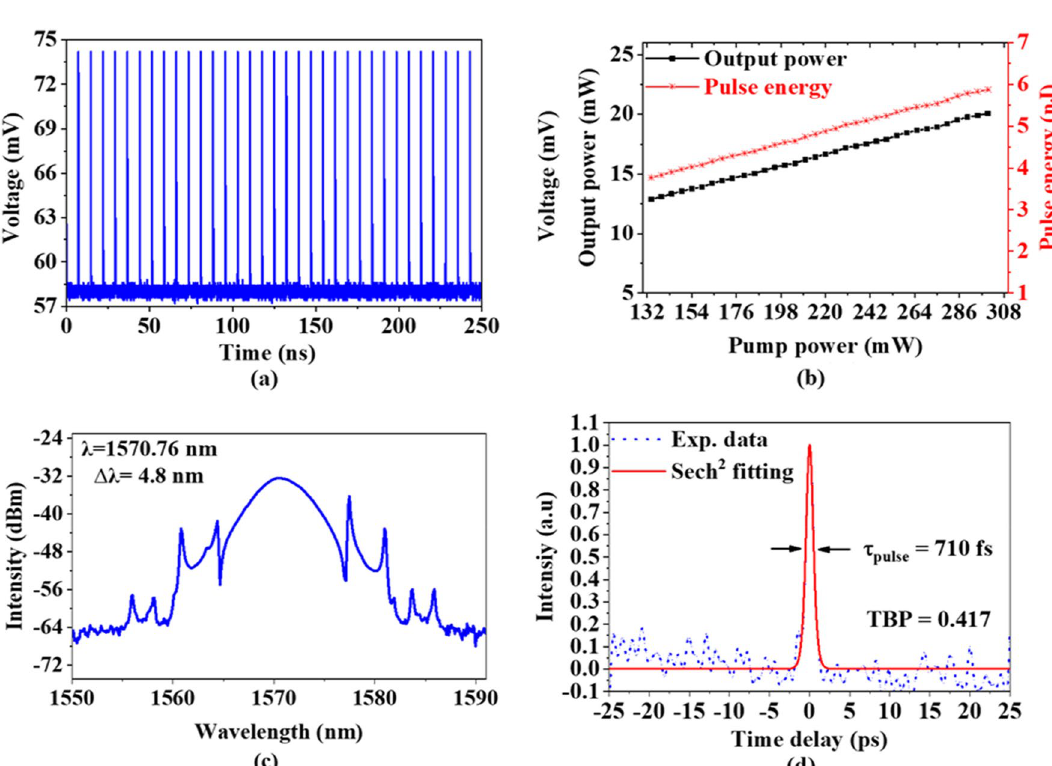
Figure 4. Characteristic of mode-locked EDFL operation ( a ) pulse train in time domain, ( b ) Pulse energy and output power changing with pump power ( c ) Optical spectrum, and ( d ) Autocorrelator